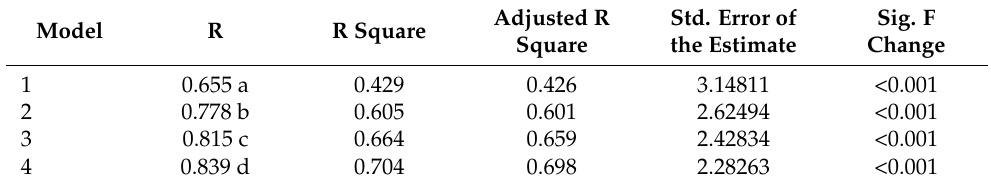
Table 8. Stepwise multiple linear regression model summary.